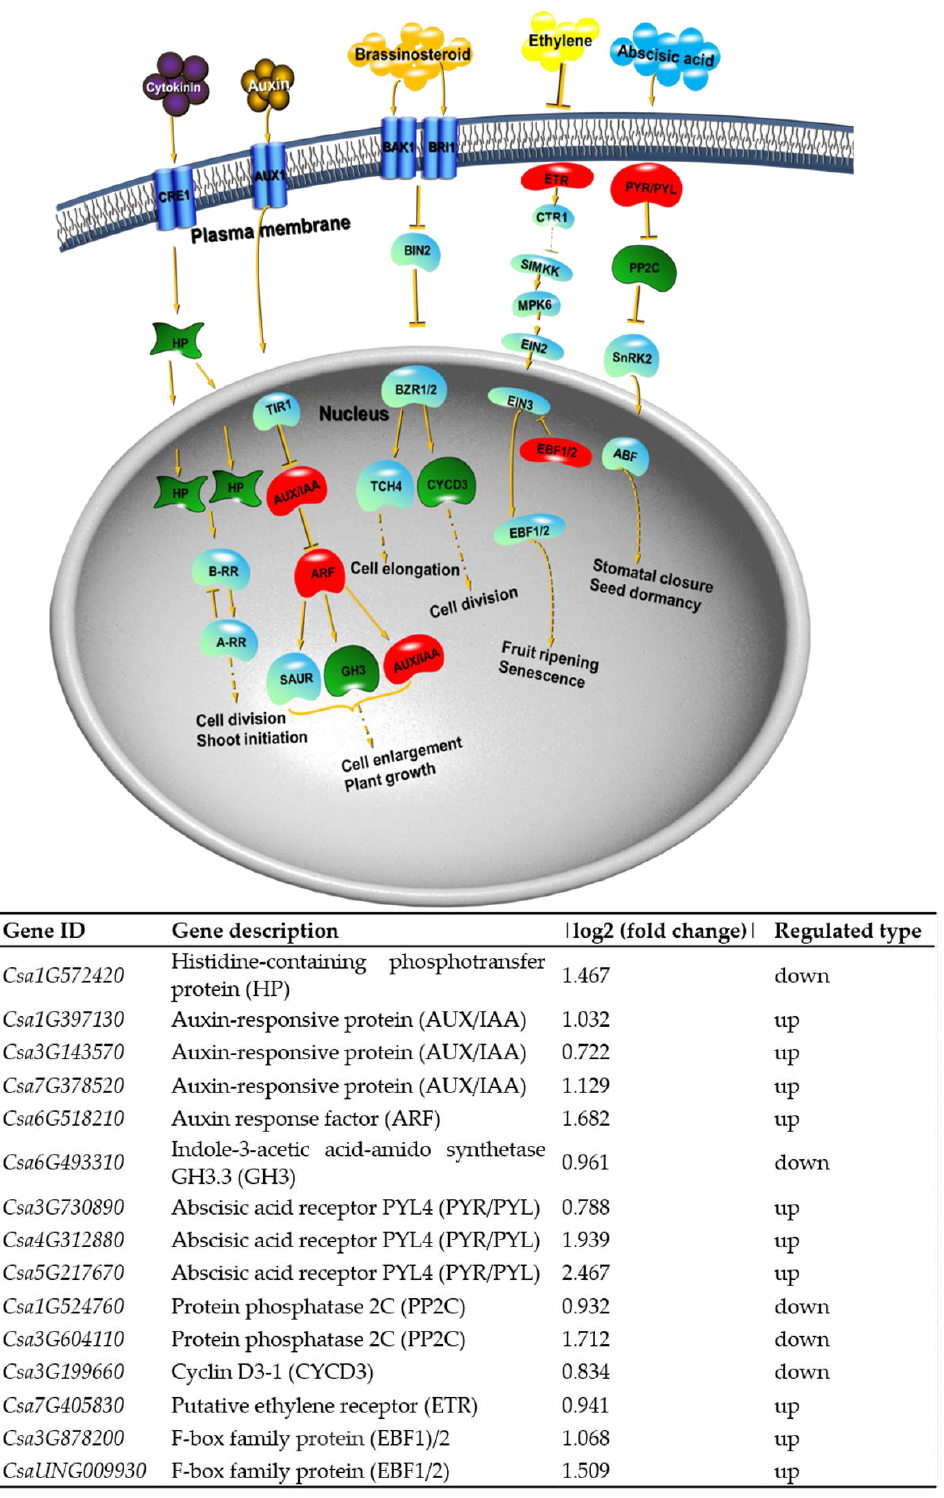
Figure 17. Schematic representation of significantly enriched pathways of plant hormone signal transduction in odd1 vs. WT. Red shapes indicate up-regulation in odd1 vs. WT; green shapes indicate down-regulation in odd1 vs. WT; and blue shapes indicate no significant changes in odd1 vs. WT.